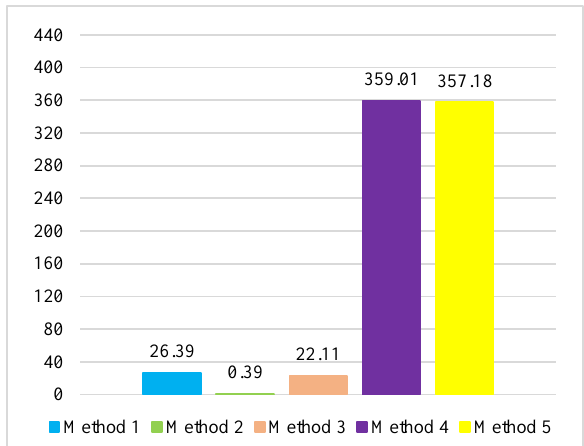
Figure 8. Comparison between the proposed method and other methods based on runtime